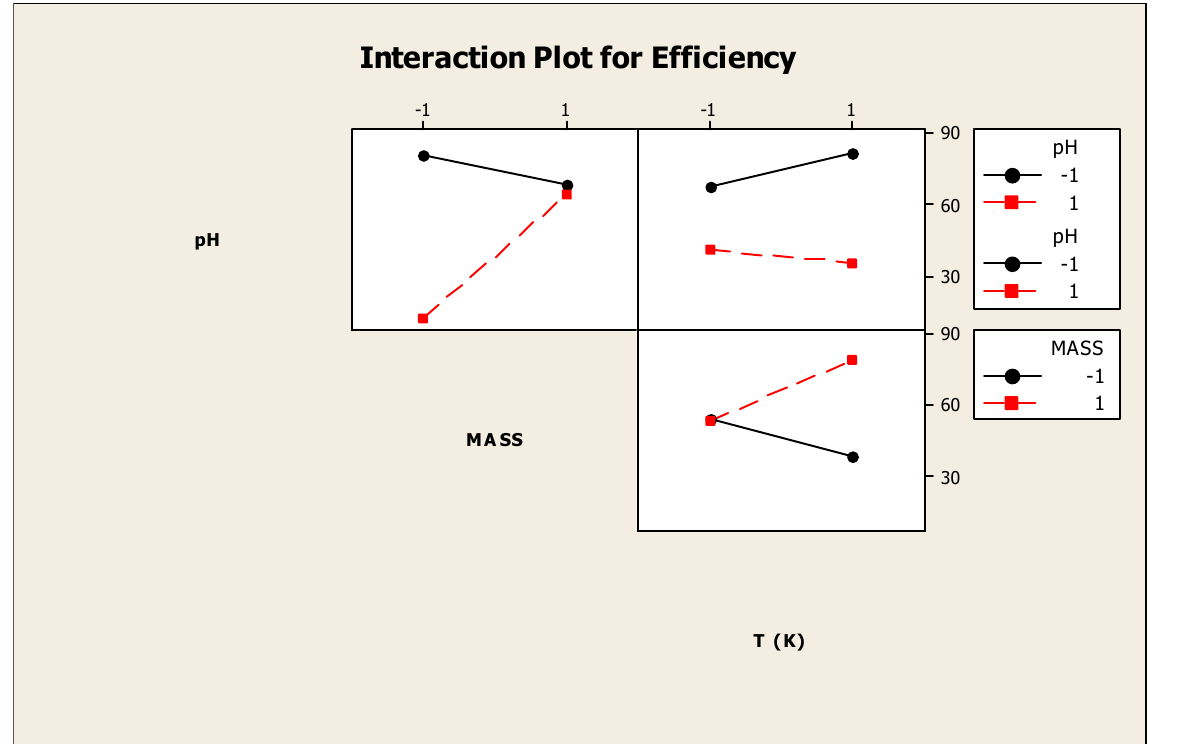
Figure 9. Effect of the investigated factors on BR dye removal efficiency.